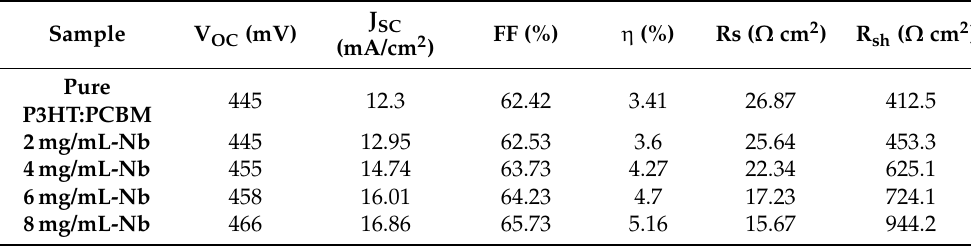
Figure 9. J–V plots of the glass/ITO/PEDOT:PSS/P3HT:PCBM:Nb/MoO 3 /Au solar cell device based on an active layer P3HT:PCBM:Nb and pure P3HT:PCBM. Table 1. Photovoltaic performance of pure P3HT:PCBM and the P3HT:PCBM:Nb solar devices were fabricated utilizing various Nb concentrations under AM 1.5 sun irradiation with 100 mW/cm 2 of light power.